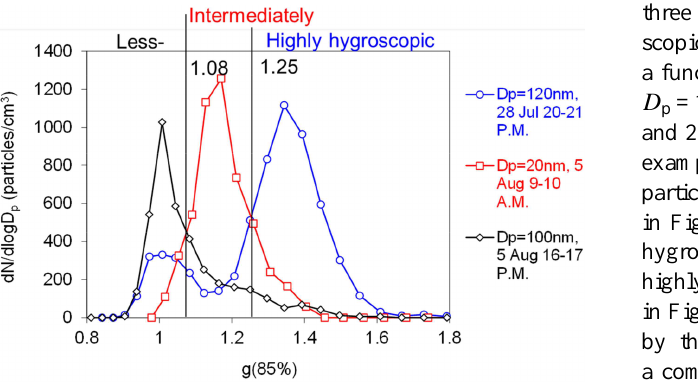
Figure 6. Lognormal number distributions of humidified particles as a function of g (85%) values on 5 August (16:00–17:00LT) at dry D p =100nm, 5 August (09:00–10:00LT) at dry D p =20nm, and 28 July (20:00–21:00LT) at dry D p =120nm as typical examples for less-, intermediately, and highly hygroscopic particles, respec- tively. Vertical lines at g (85%) values of 1.08 and 1.25 represent threshold values between less-, intermediately, and highly hygro- scopic fractions. g (85%) at dry D p =20nm is Equiv. g (85%) at dry D p